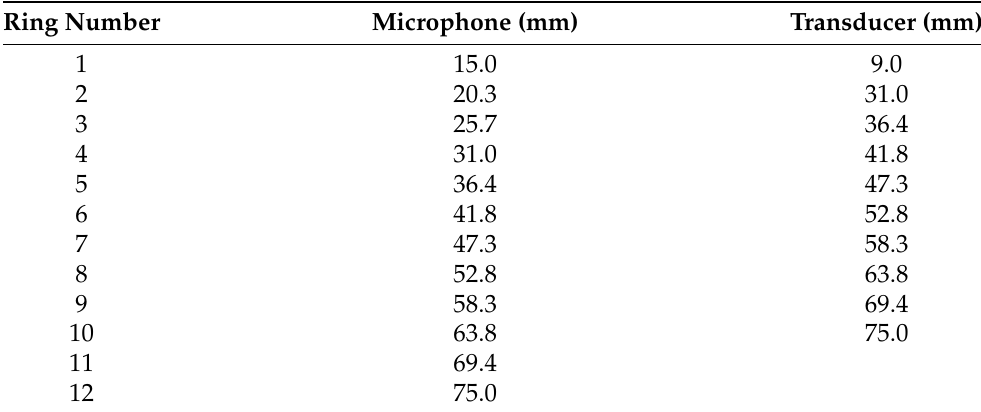
Table 1. Radii of microphone and transducer rings.